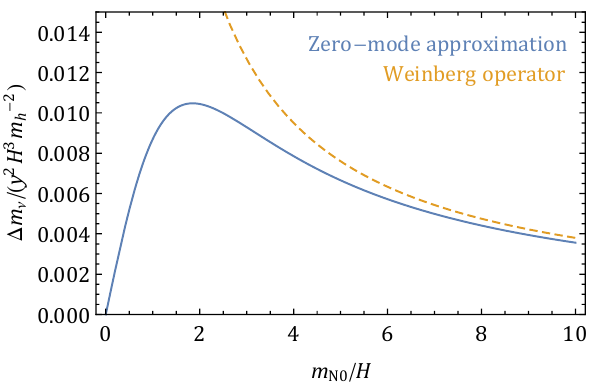
Figure 1 . 1-loop corrections to the mass of the left-handed neutrino (cid:1) m (cid:23) as functions of right- handed neutrino mass m N 0 . The blue solid curve shows the correction from Yukawa interaction derived in (3.6) with zero-mode approximation, while the dashed orange curve shows the correction from the e(cid:11)ective Weinberg operator valid in large m N 0